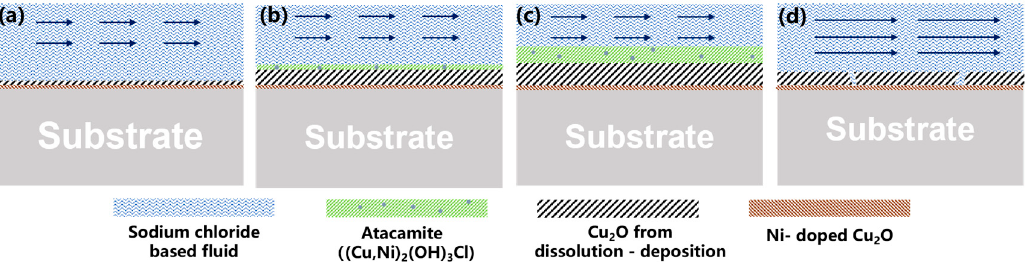
Figure 12. Effect of flow velocity on the corrosion product film of the 70/30 copper–nickel alloy in a sodium chloride-based fluid: ( a – c ) the schematics of the corrosion product film formation process at low flow velocities of 0.5–3 m/s; ( d ) the schematics of the corrosion product film formed at 4–4.7 m/s.